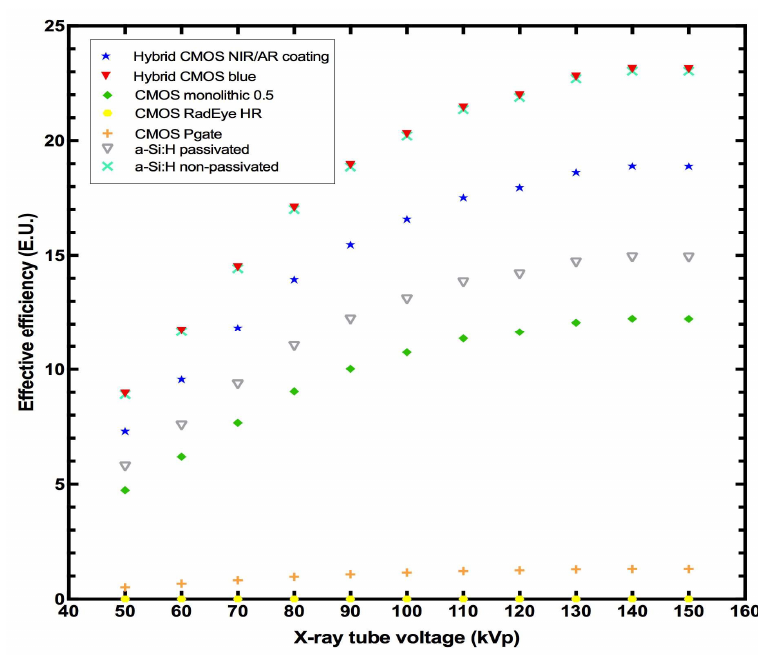
Figure 16. EE of LaBr 3 :Ce combined with various CMOS.